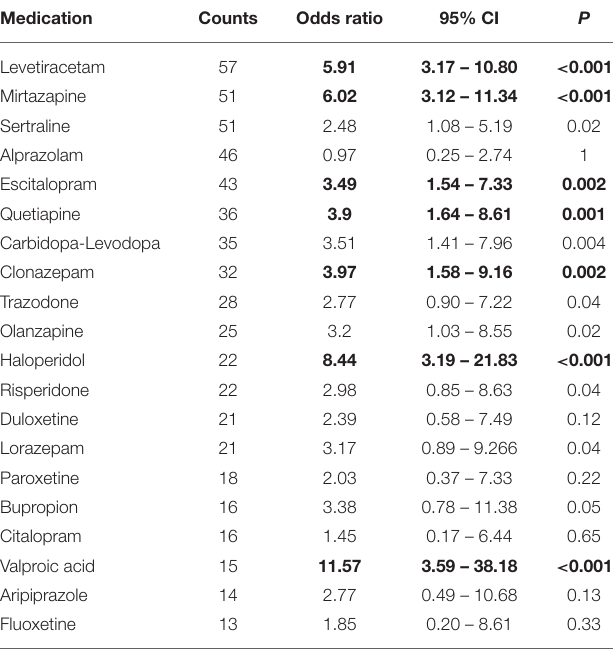
TABLE 3 | Association of individual psychotropic medications with post-COVID dementia.